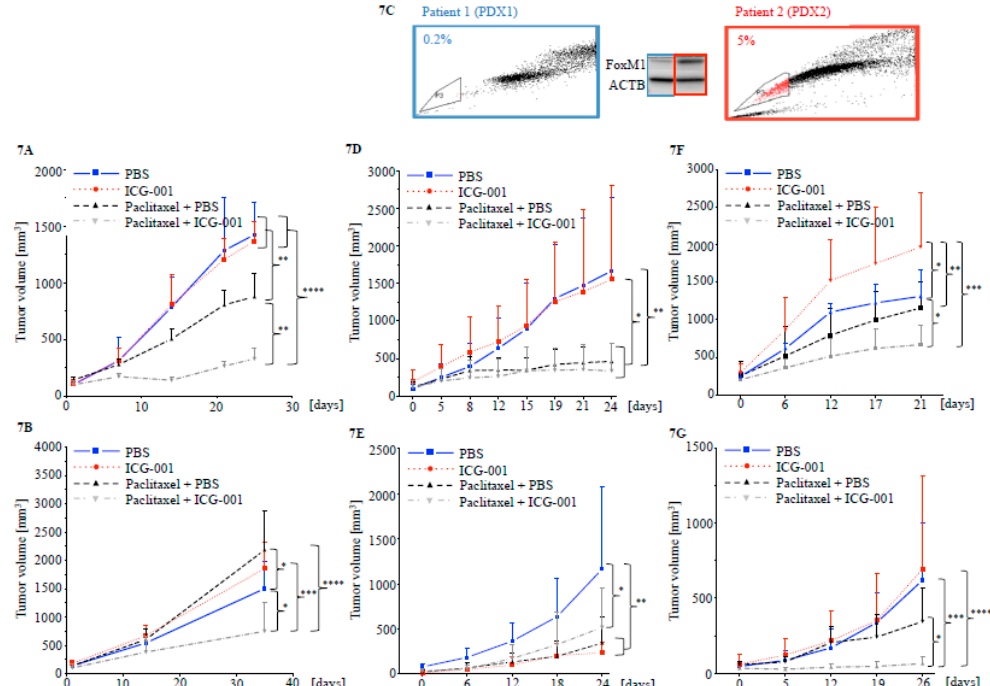
Figure 7. ICG-001 sensitizes TNBC cell line xenografts to Paclitaxel treatment and reduces tumor initiation capacity. ( A ) MDA-MB-468 TNBC cell xenograft in female Nod/SCID/gamma (NSG) mice treated for 26 days ( n = 4 mice per treatment condition). Results were statistically significant for PBS vs. Paclitaxel + PBS, ICG-001 vs. Paclitaxel + PBS, PBS vs. Paclitaxel + ICG-001, ICG-001 vs. Paclitaxel + ICG-001 and PBS vs. Paclitaxel + PBS vs. Paclitaxel + ICG-001. ( B ) Secondary implantation of MDA-MB-468 tumors from primary xenografts. Tumors were dissociated after termination of the experiment and implanted into new female NSG mice without further treatment ( n = 5 mice per treatment condition). Results were statistically significant for PBS vs. Paclitaxel + PBS, ICG-001 vs. Paclitaxel + PBS, PBS vs. Paclitaxel + ICG-001, ICG-001 vs. Paclitaxel + ICG-001 and PBS vs. Paclitaxel + PBS vs. Paclitaxel + ICG-001. ( C ) FOXM1 protein expression and proportion of side population cells in tumors from two TNBC patients. ( D , E ) PDX1 tumor growth and treatment response after primary implantation (results were statistically significant for PBS vs. paclitaxel + PBS, PBS vs. paclitaxel + ICG-001, ICG-001 vs. paclitaxel + PBS and ICG-001 vs. paclitaxel + ICG-001) ( D ) and secondary implant without further treatment (results were significant for PBS vs. ICG-001, PBS vs. paclitaxel + PBS and PBS vs. paclitaxel + ICG-001) ( E ). ( F and G ) PDX2 tumor growth and treatment response after primary implantation (results were statistically significant for PBS vs. ICG-001, PBS vs. paclitaxel + ICG-001, ICG-001 vs. paclitaxel + PBS and ICG-001 vs. paclitaxel + ICG-001) ( F ) and secondary implant without further treatment (results were statistically significant for PBS vs. paclitaxel + ICG-001, ICG-001 vs. paclitaxel + ICG-001 and ICG-001 vs. paclitaxel + PBS) ( G ). (* p < 0.05, ** p < 0.01, *** p < 0.001, **** p < 0.0001) .